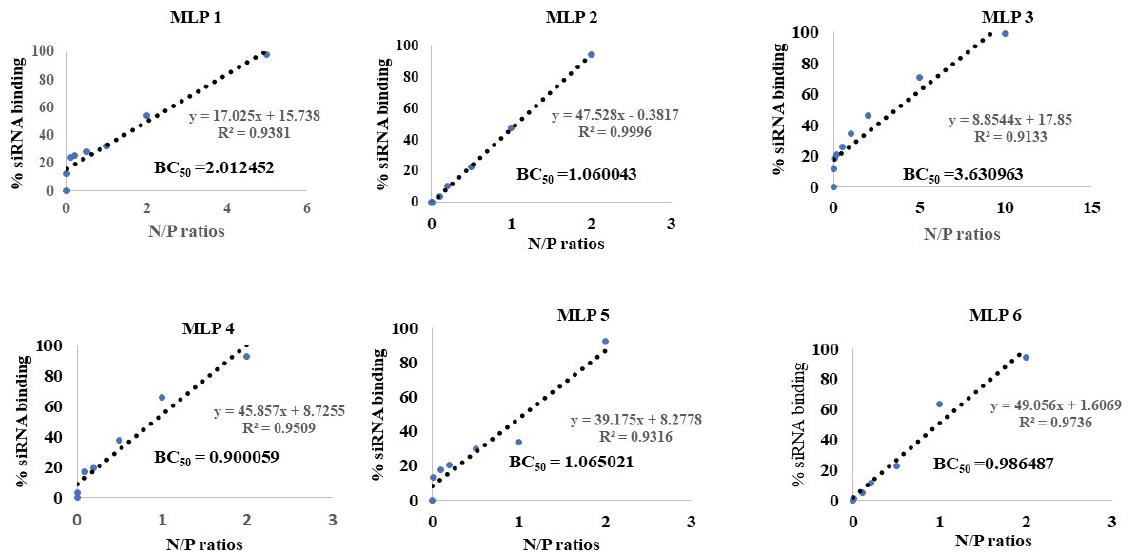
Figure 3. The plots representing the BC 50 value estimation based on the quantified bands of the gels represented in Figure 2.